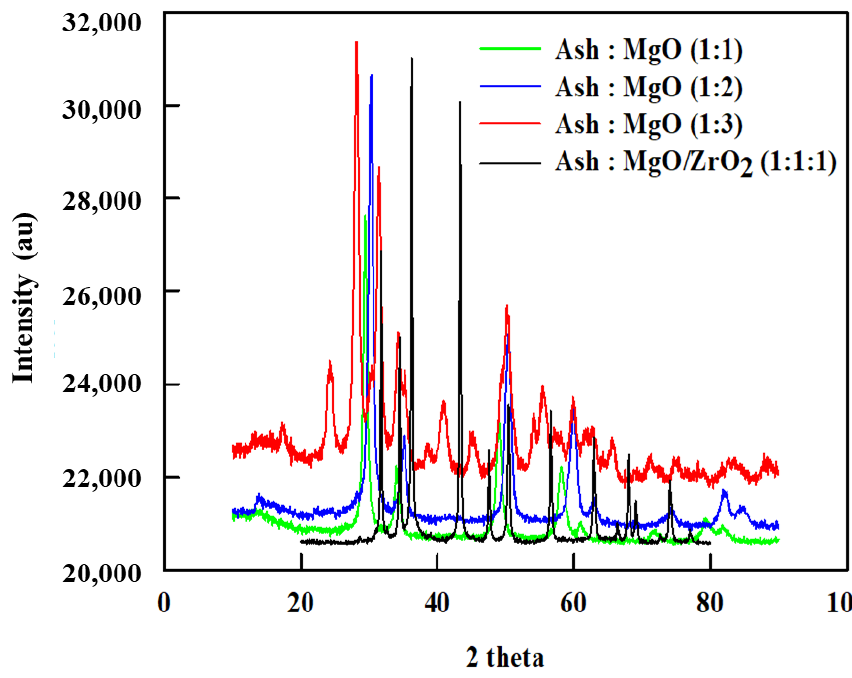
Figure 1. XRD pattern of Ash:MgO (1:1), (1:2), (1:3) and Ash:MgO/ZrO 2 (1:1:1). Ash + MgO (1:1) and (1:2) have a mixture of both a greater degree of crystallinity and amorphousness, while (1:3) has a higher intensity of crystal. Ash + MgO/ZrO 2 (1:1:1) also displayed some crystallinity patterns.